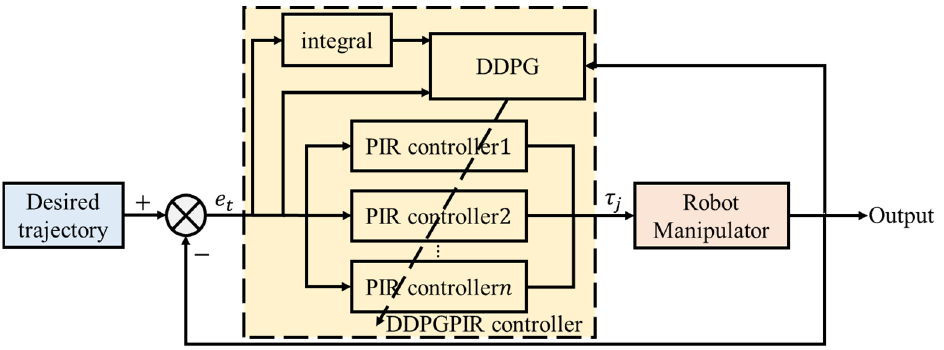
Figure 1. Schematic diagram of the DDPGPIR control system.